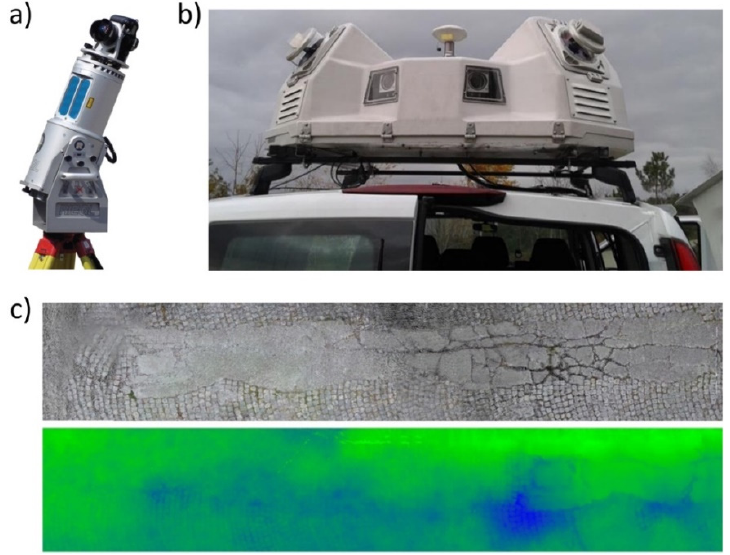
Figure 4. LiDAR. ( a ) Terrestrial laser scanner (Riegl LMS Z-390i), ( b ) Mobile Mapper Scanner (Lynx), and ( c ) RGB orthoimage and Z-value orthoimage (Z or height values of the point cloud; from 0 cm (dark blue) to 35 cm (dark green)) showing pavement pathologies (adapted from